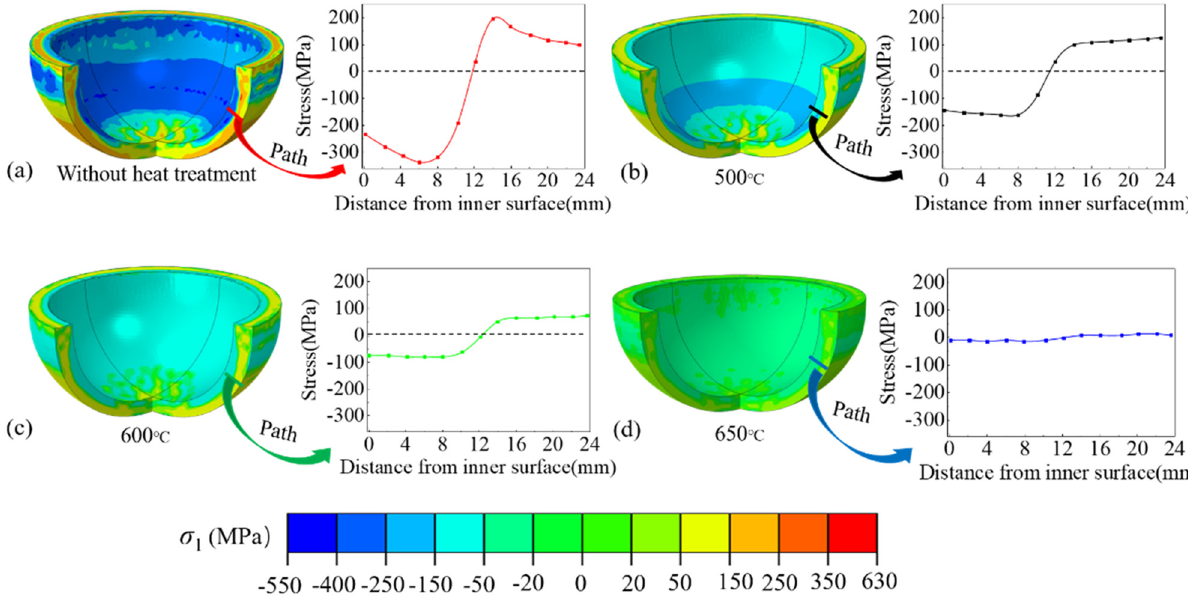
Figure 8: Residual stress distributions ( a ) after cold - forging, and after annealing at ( b ) 500°C, ( c ) 600°C, and ( d ) 650°C.